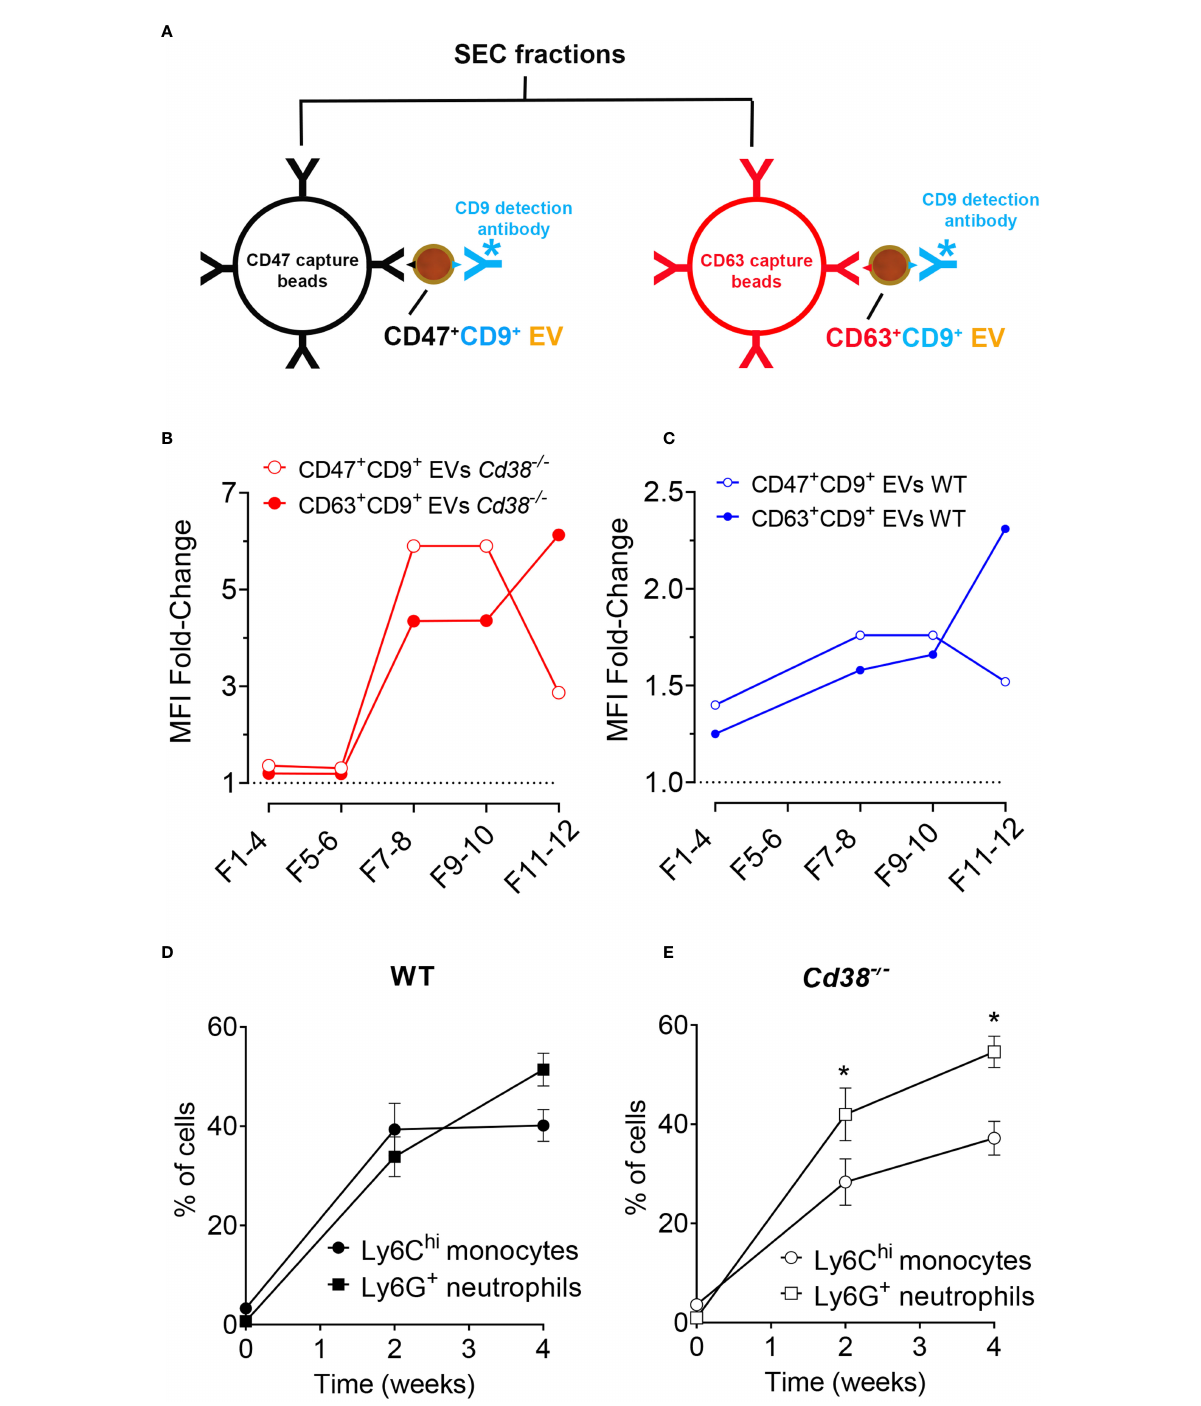
FIGURE 10 (A) Diagram showing the strategy used to immunocapture CD47 + EVs with anti-CD47-coated magnetic beads (in black), or CD63 + EVs (in red). Then, EV-coated beads were labeled with anti-CD9-biotin/Streptavidin-PE and analyzed by fl ow-cytometry. (B) Immunocapture of CD47 + EV (red solid circles) or CD63 + EV (open red circles) from SEC fractions of Cd38 -/- EV from peritoneal exudates of pristane-treated mice. (C) Immunocapture of CD47 + EV (red solid circles) or CD63 + EV (open red circles) from SEC fractions of WT EV. (D) Time-course of frequencies of LyC hi monocytes and Ly6G + neutrophils in PECs from WT mice upon pristane treatment. (E) Time-course of frequencies of LyC hi monocytes and Ly6G + neutrophils in PECs from Cd38 -/- mice upon pristane treatment. *Multiple unpaired t-test. Adjusted P value = 0.020890. Holf-S ̌ ida ́ k method. In (D, E) , the number of individual samples analyzed were n = 3, before pristane treatment; n = 12, 2 weeks after pristane treatment; n = 8, 4 weeks after pristane